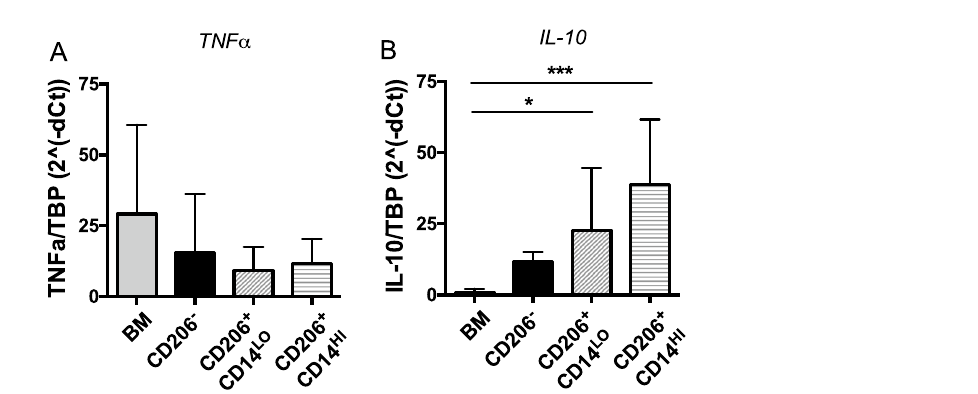
Figure 3. Expression of TNFα and IL-10 of FACS-purified healthy intestinal myeloid populations. ( A ) TNFα and ( B ) IL-10 expression were determined by qRT-PCR. CD64 + HLA-DR + CD206 + cells were subdivided into CD14LO and CD14HI populations. Expression of both cytokines was compared to blood monocytes (BM). Intestinal macrophages derived from normal colon resections; n = 6, 4, 8 and 10 for BM, CD206 − , CD206 + CD14LO and CD206 + CD14HI, respectively. Error bars show +